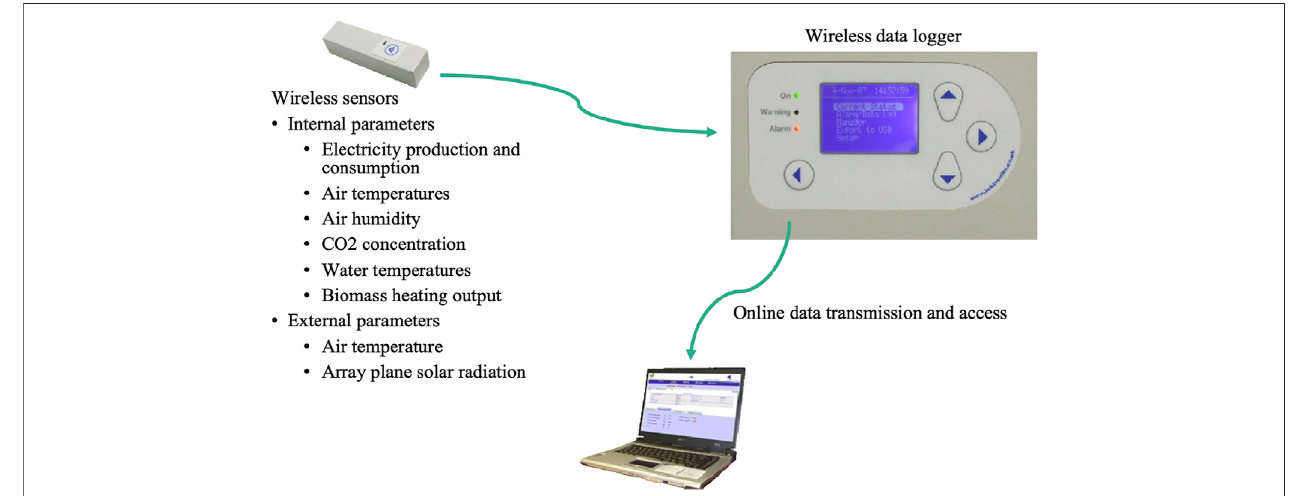
FIGURE 6 | Diagram of the instrumentation system for environmental performance